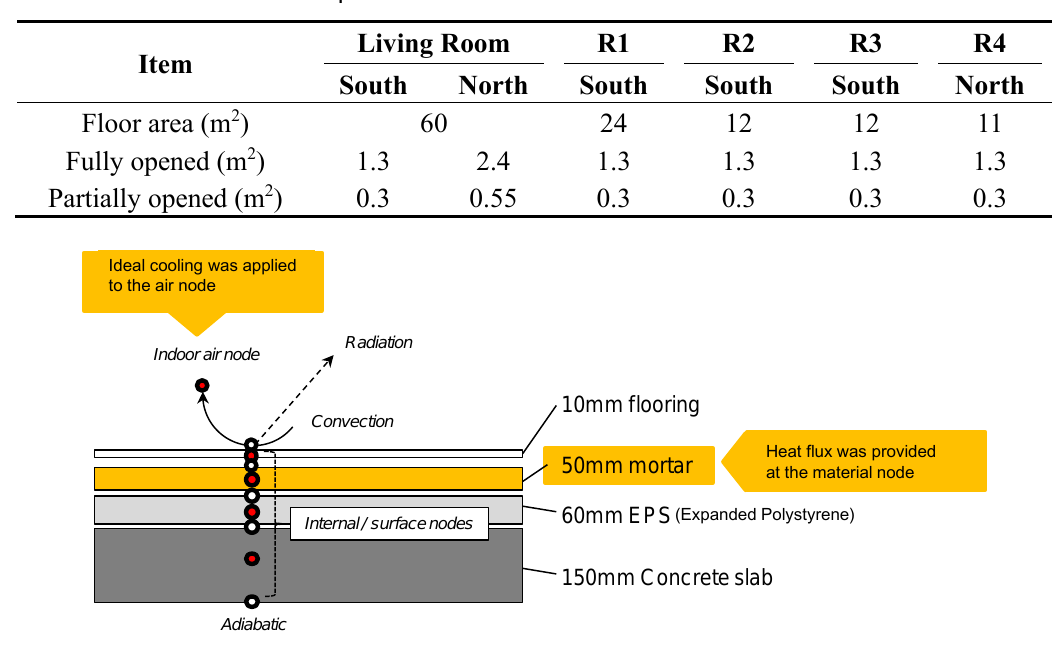
Table 6. Operable window area for natural ventilation.